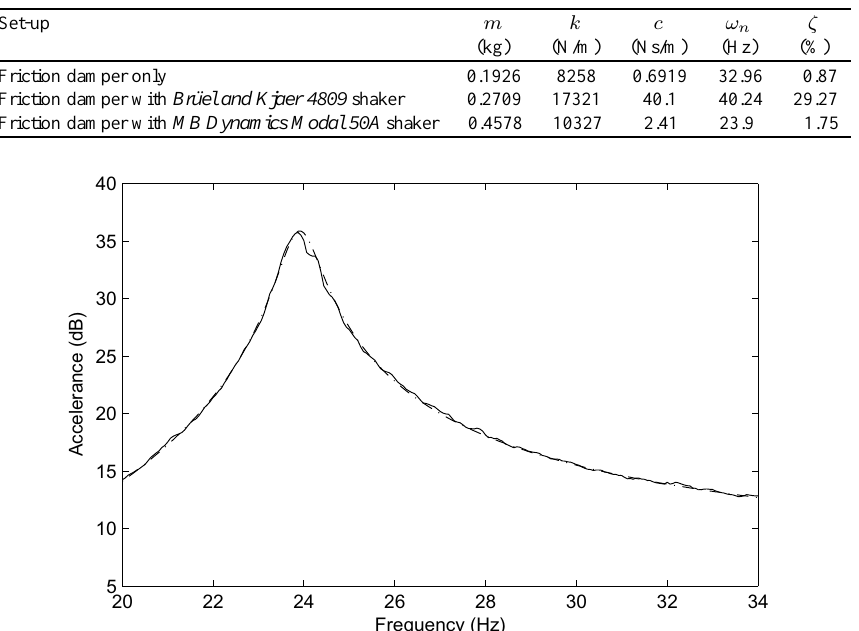
Fig. 9. Experimental and theoretical frequency response functions for the set-up with the MB Dynamics Modal 50A shaker, without any friction force. Experimental frequency response function ( −− ) and theoretical frequency response function from identification ( ·−· ). 3. Subtract the parameters k and c previously identified in order to obtain γ N σ 0 and γ N σ 1 ; 4. Run the optimization-based static parameters identification algorithm in order to determine θ =